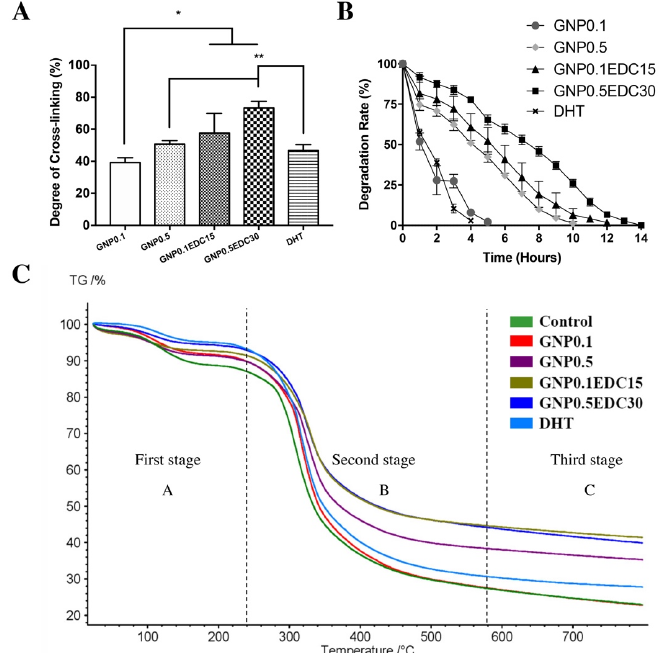
Figure 2. Effect of crosslinking on gelatin sponge (GS) biostability. ( A ) Measurement of crosslinking degree using ninhydrin assay. Double crosslinking and a higher concentration of crosslinker resulted in a higher crosslinking degree. Significant difference was observed between GNP0.1 and the DHT group with the other group; */** represent a significant difference ( p < 0.05; n = 3, N = 5) between groups. ( B ) GS degradation under enzymatic hydrolysis. Double crosslinking and higher concentration of crosslinker resulted in longer degradation time. ( C ) Mass change of GS as a function of temperature. Double crosslinking and higher concentration of crosslinker resulted in reduced